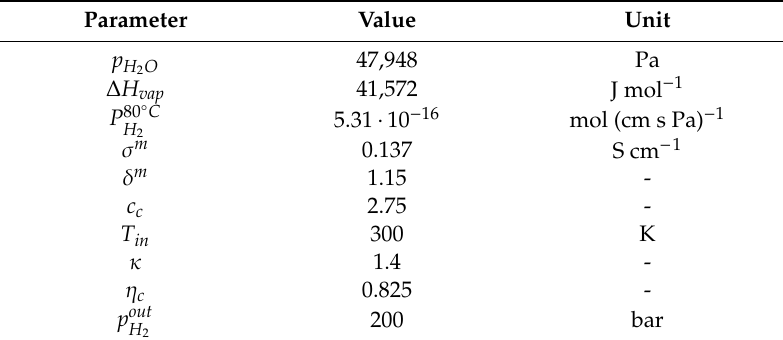
Table 1. Parameter values used for this work.